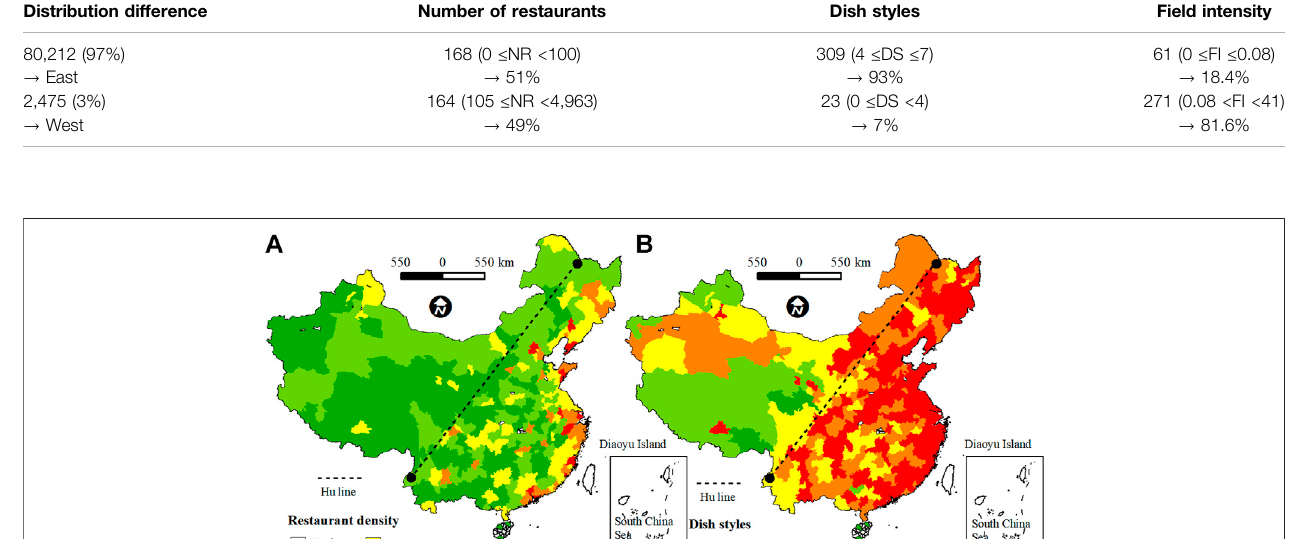
Frontiers in Earth Science |